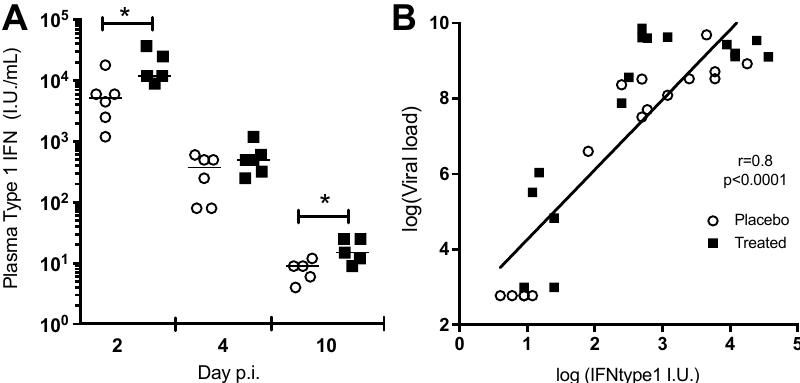
Figure 3. The type 1 interferon response and plasma viral load during acute chikungunya. ( A ) Type 1 interferon concentration was higher in the chloroquine group (black squares) than in the placebo group (open circles) on day 2 pi (viral load peak) and day 10 pi (during clearance). * p < 0.05, Mann & Whitney test; ( B ) Type 1 interferon concentration is correlated with plasma viral load during acute chikungunya (Spearman’s rank test, rho = 0.8, p < 0.0001).